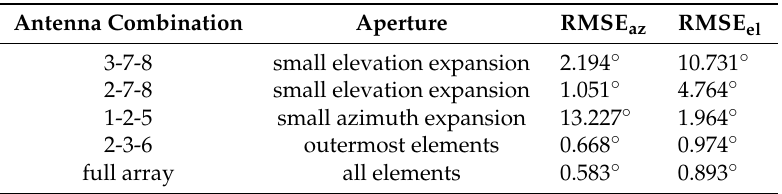
Table 1. RMSEs for combinations of three antenna elements.